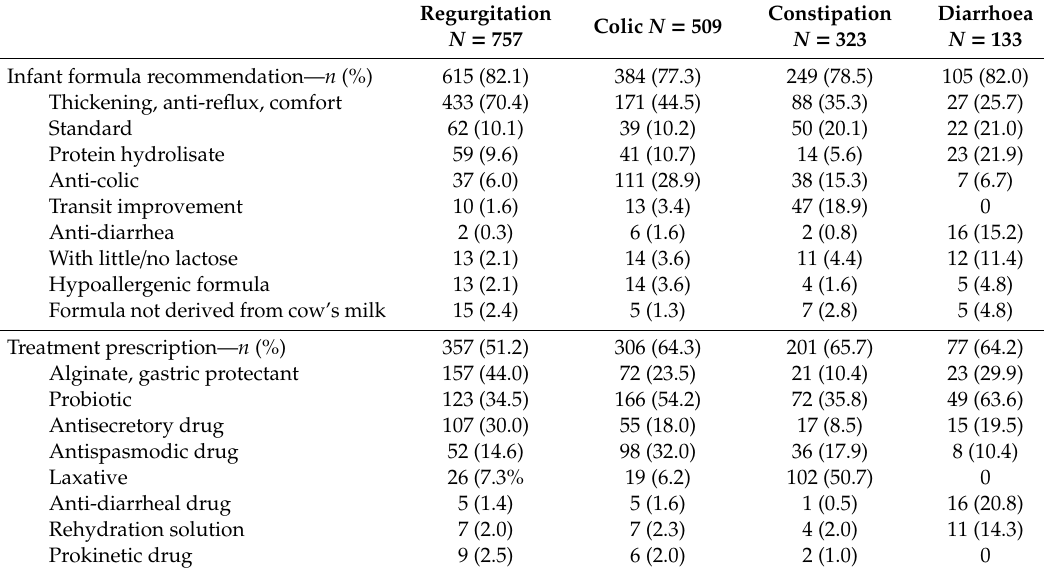
Table 4. Management of infants with functional gastrointestinal